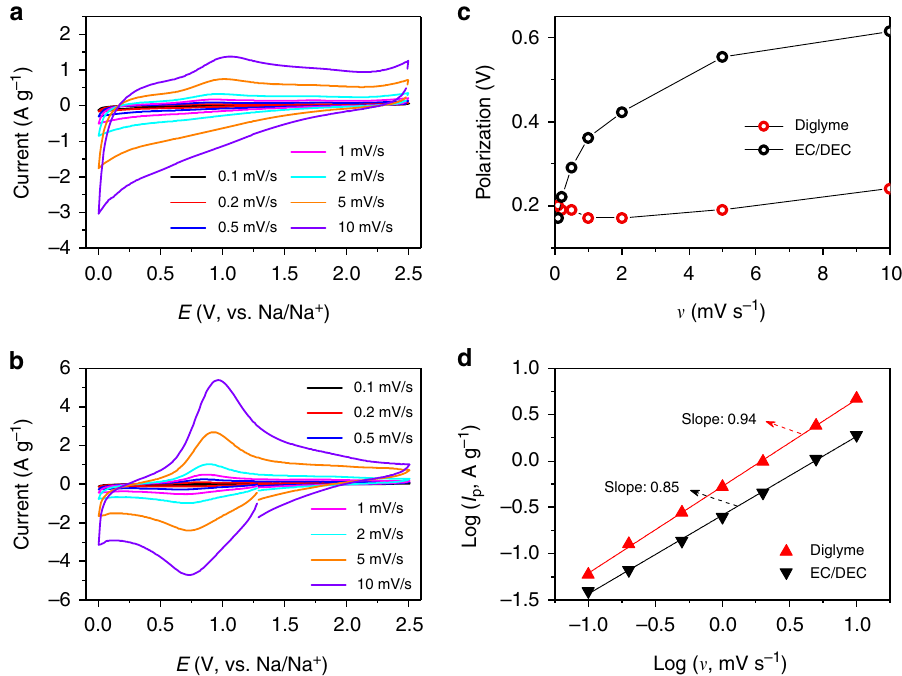
Fig. 3 Scan rate-dependent cyclic voltammetry (CV) from the 3-electrode tests (see the experimental setup in Supplementary Figure 12). a , b CV curves of the TiO 2 anode at different scan rates with the EC/DEC-based electrolyte ( a ) and the diglyme-based electrolyte ( b ). c Separation (potential polarization) between the cathodic and anodic peaks in the CV curves as a function of scan rate. d b -values (slopes) obtained from the current peaks, I p = av b , of the CV